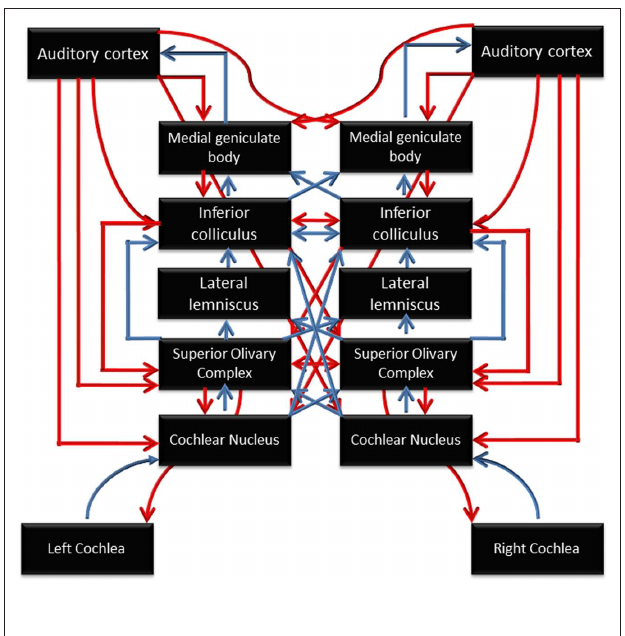
FiguRE 2 | Schematic diagram of the auditory system, illustrating the many subcortical processing stations between the cochlea (bottom) and cortex (top). Blue arrows represent ascending (bottom-up) pathways; red arrows represent descending projections. From Chandrasekaran and Kraus (2010), reproduced with permission.